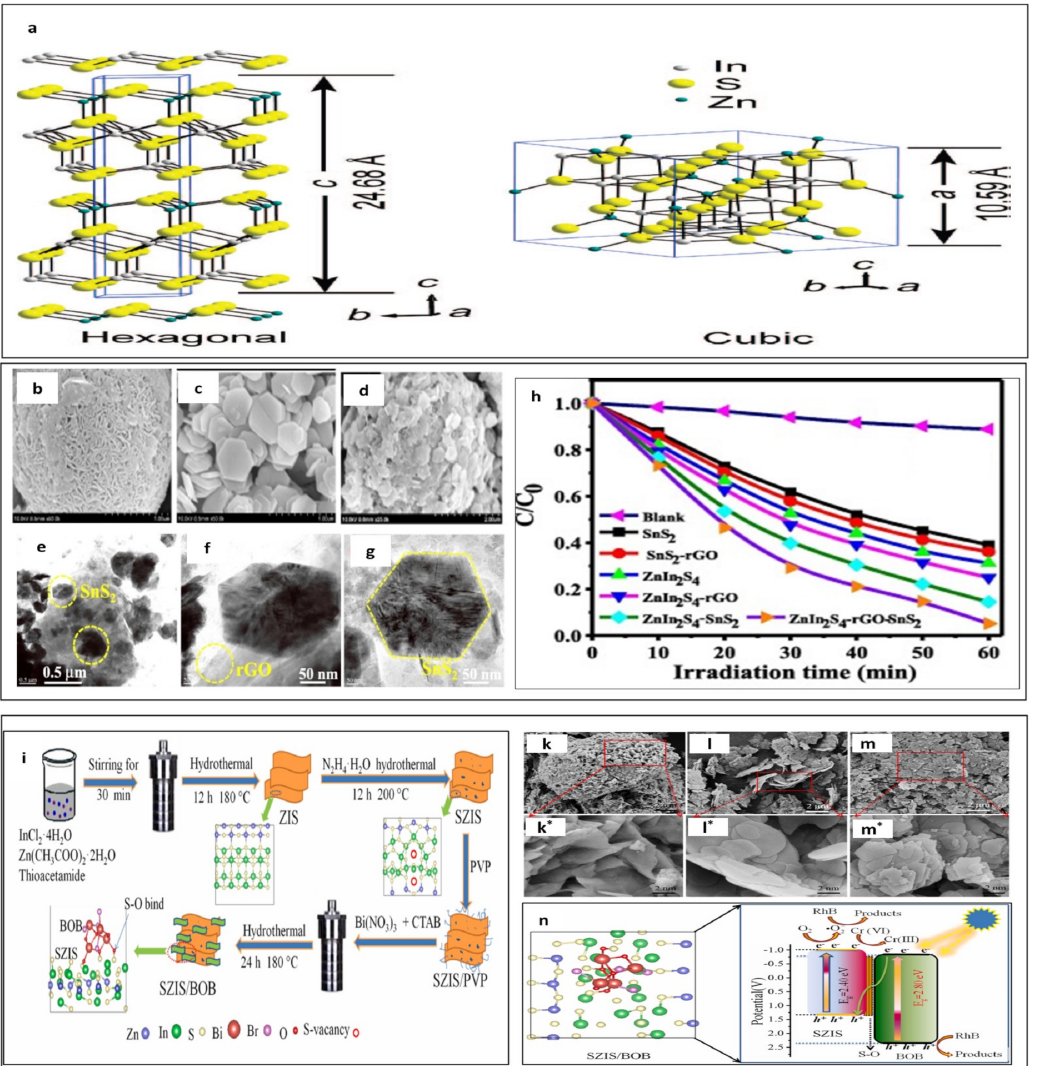
Figure 8. The crystal structures of ZnIn 2 S 4 (reprinted with permission from [197] Copyright